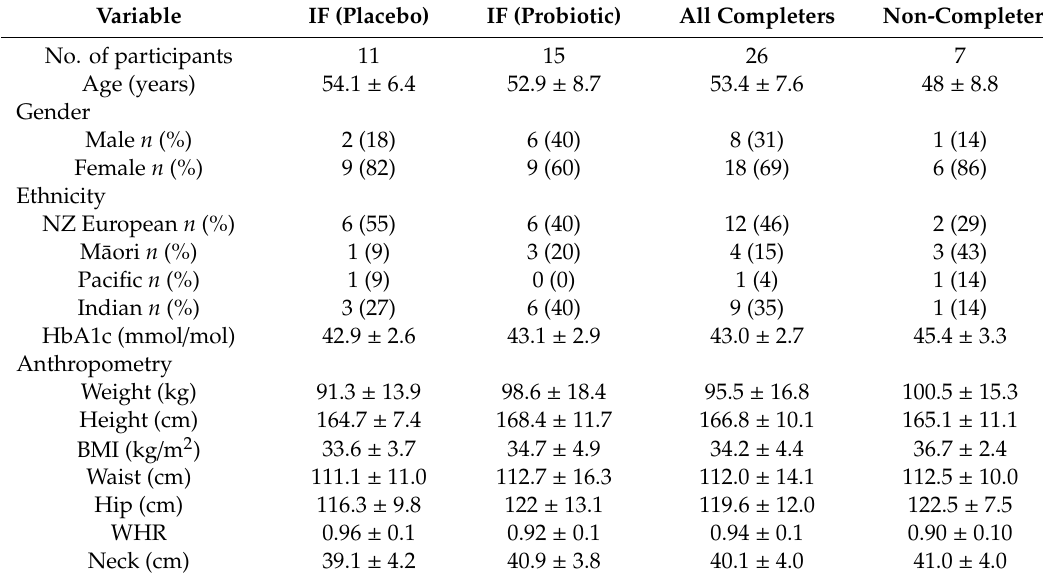
Baseline characteristics for participants according to intervention allocation and completion